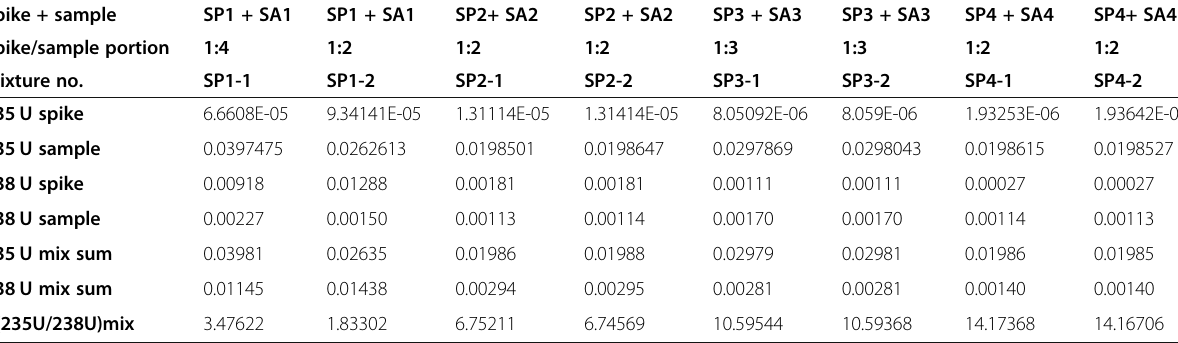
All mixtures simulated with duplicates. Ratio of U 235 /U 238 mixture is not corrected for the mass fractionation. It will be taken into account for the extended uncertainty estimations